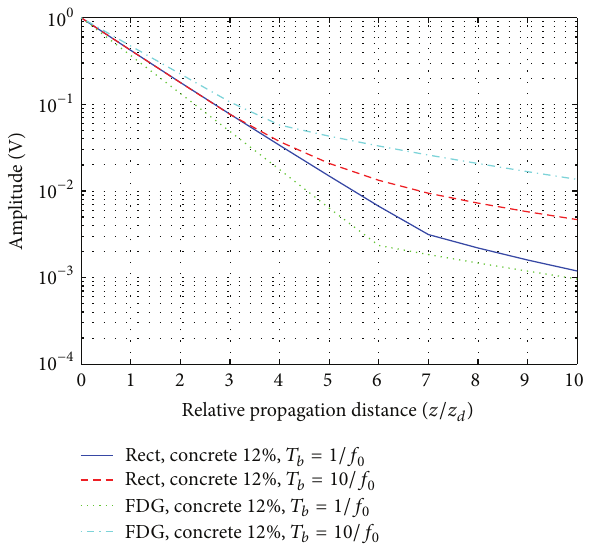
Figure 10: Peak amplitude as a function of propagation distance through wet concrete (12% moisture) for rectangular and FDG pulses of duration 𝑇 𝑏 = 10/𝑓 0 and 𝑇 𝑏 = 1/𝑓 0 at 𝑓 0 = 1.5